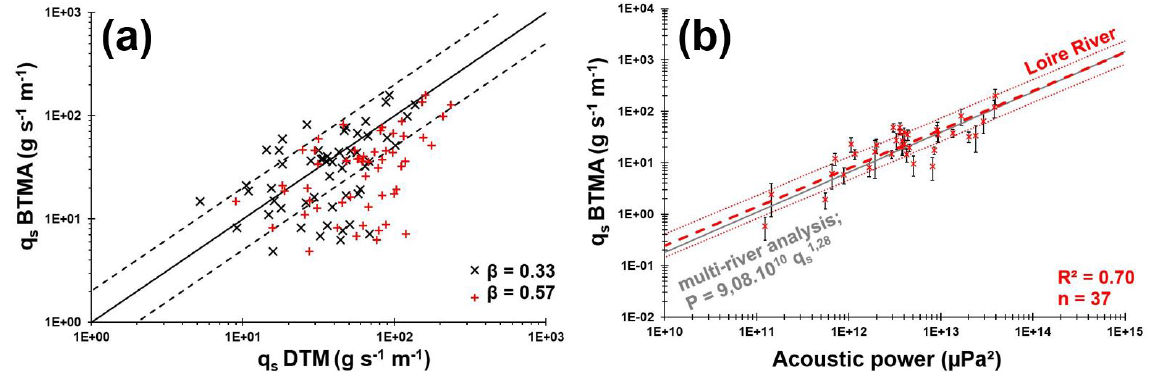
Figure 5. (a) The log–log correlation between bedload rates measured with BTMA samplers and bedload rates calculated using Eq. (13). The solid black line represents the perfect correlation and dashed black lines represents a factor of 2 of the perfect correlation. (b) Unit bedload rates measured with BTMA samplers as a function of acoustic power measured with hydrophone. Dashed red lines represent the RMA regression with envelopes curves of a factor of 2 of the bedload rates. Compare with Geay et al. (2020).